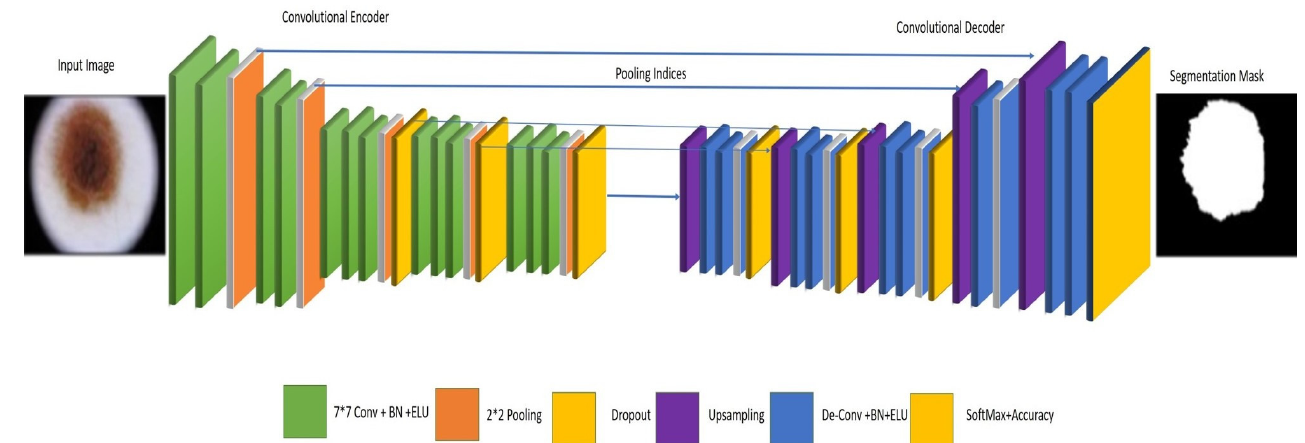
Figure 3. Segmentation of skin lesions by our proposed neural network